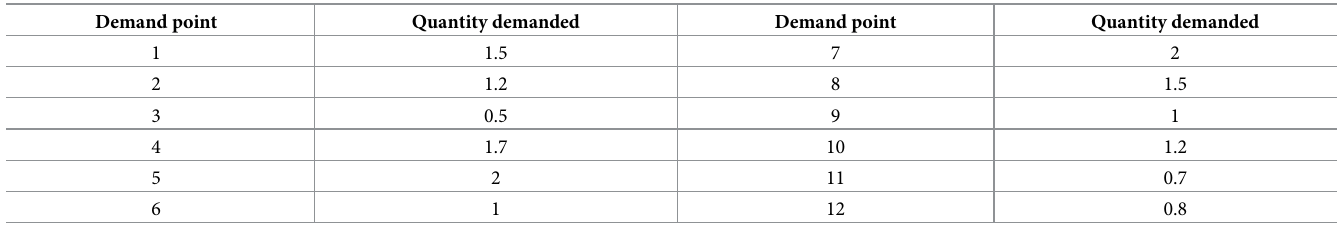
Table 1. Transport task information.